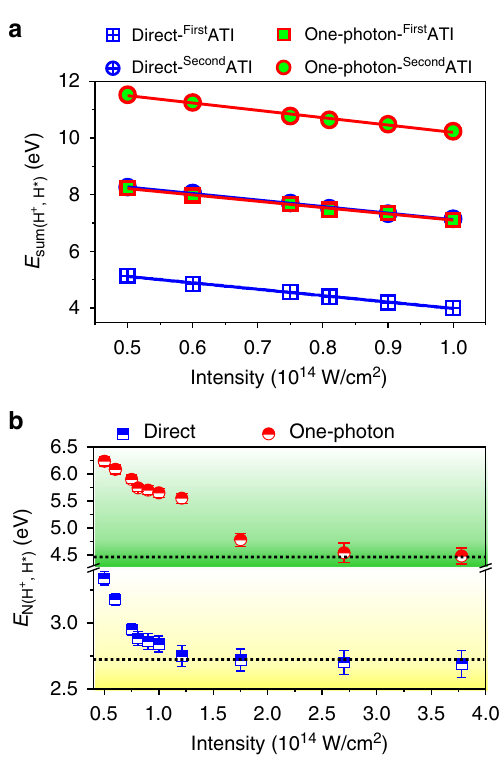
Fig. 4 Laser intensity-dependent peak locations of the E N and E sum spectra. a The energy of the fi rst and second ATI peaks of the E sum spectra of the direct and one-photon pathways of the (H + , H * ) channel as a function of the laser intensity. b Laser intensity-dependent locations of the peaks of the + , H * ) channel. E N spectra of the direct and one-photon pathways of the (H The statistical error bars for E represent the uncertainty of N ð H þ , H ? Þ Gaussian fi ts of the E N spectra during data analysis. The black dotted lines indicate the calculated low limit of the E N related to the direct and one- photon